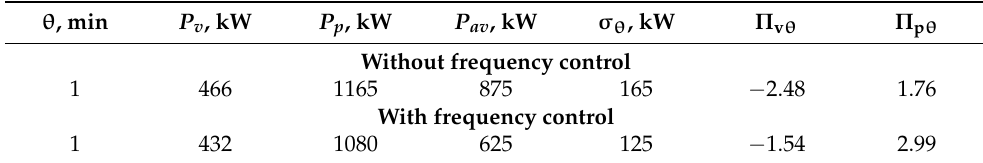
Table 15. Calculated values of the limits of change of the ordinates.